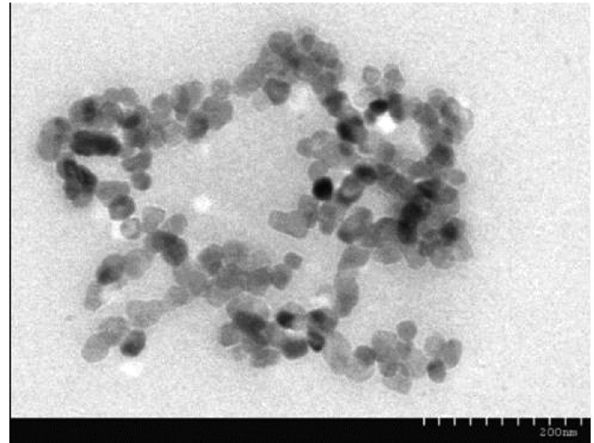
Figure 3: TEM view of nano - CaCO 3 [ 61 ] .